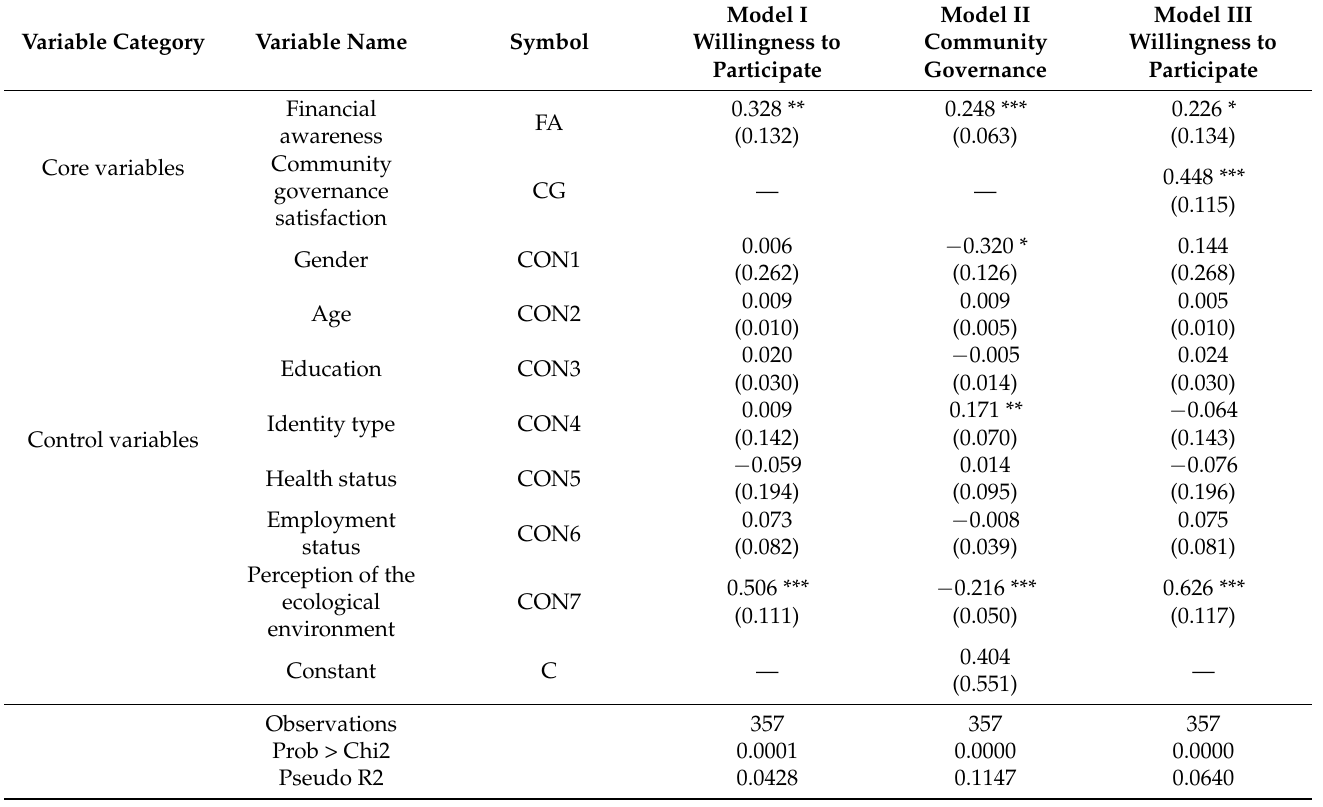
Table 4. Influence of financial awareness and community governance on residents’ willingness to participate in the development of the Giant Panda National